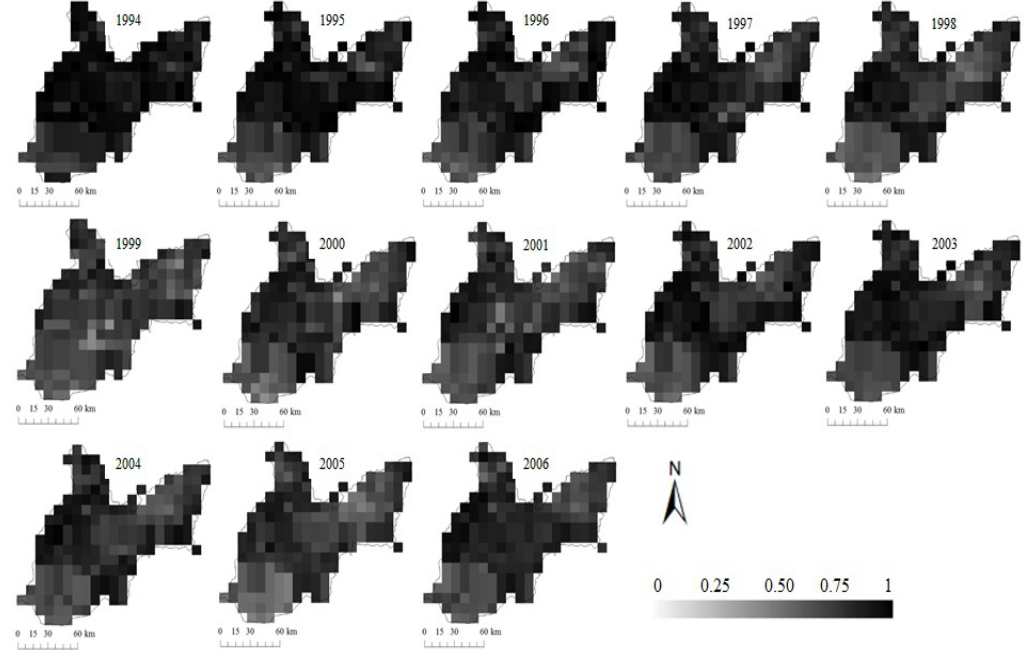
Figure 4. Maximum NDVI value composite from the first fifteen days of January for the period of 1994–2006.